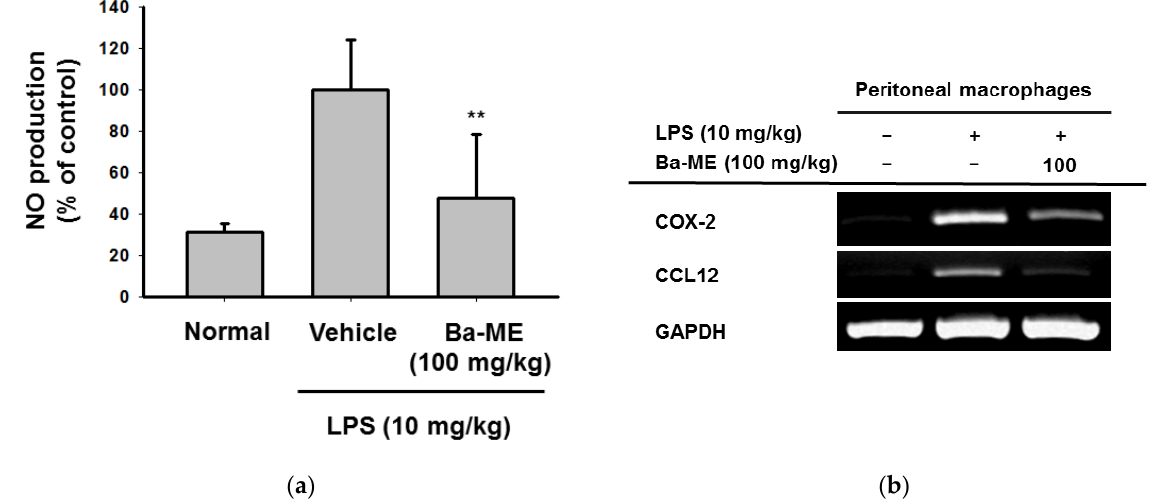
Figure 5. Effect of Ba-ME on regulating inflammation in an LPS-induced peritonitis mouse model. ( a ) Peritoneal macrophage inflammatory lesions were examined with an NO assay. ( b ) The mRNA expression levels of COX-2, CCL12, and GAPDH in peritoneal macrophages treated with Ba-ME (100 mg/kg) were determined using semiquantitative RT-PCR. ** p < 0.01 compared with control cells. The values ( a ) are presented as mean ± SD of 5 replicates.